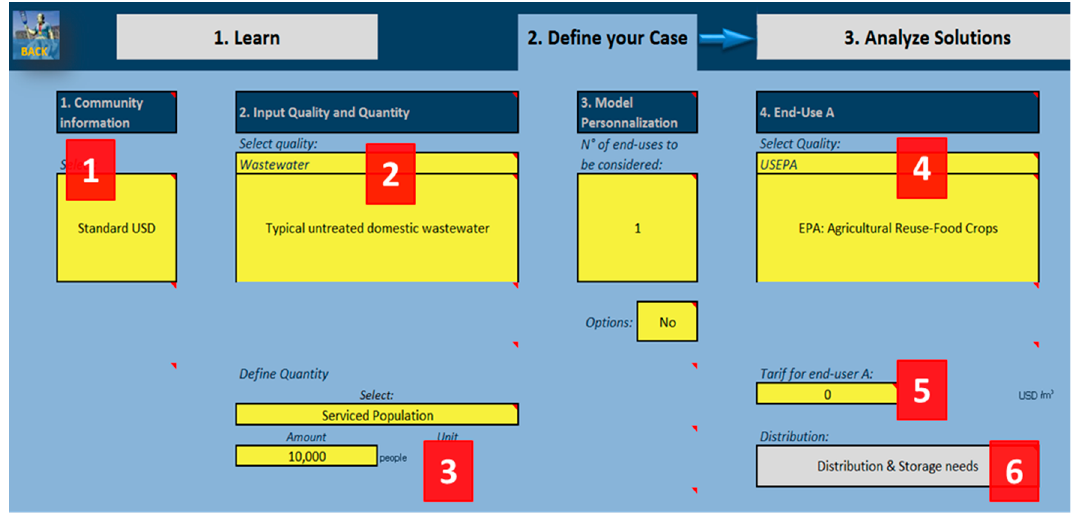
Figure 5. Data input in simple mode.